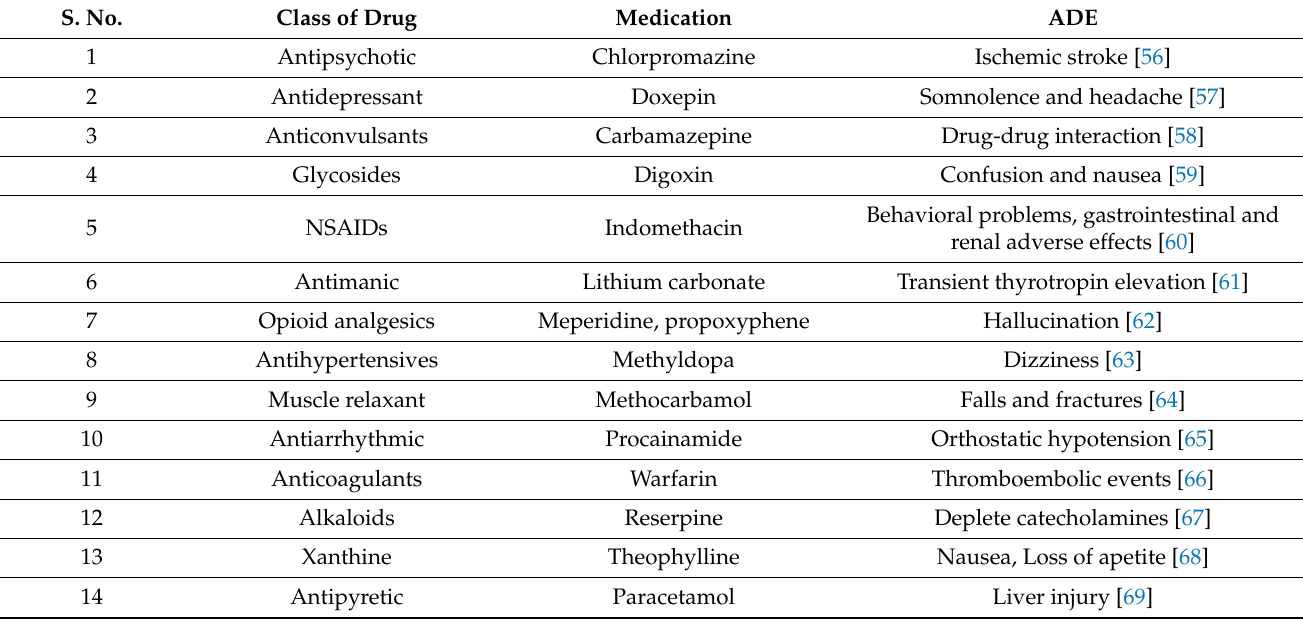
Table 1. Adverse drug events of some medications in older